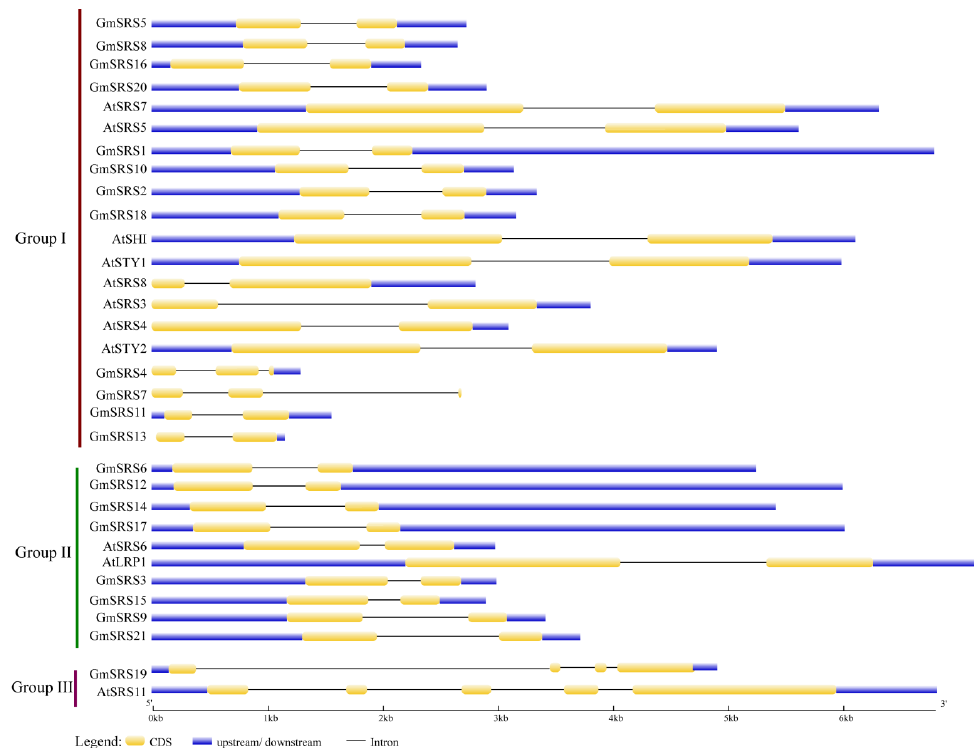
Figure 3. Intron-exon structures of SRS genes in soybean and Arabidopsis . The GSDS online tool was used to produce the intron-exon structures. The exons, introns, and untranslated regions (UTRs) are indicated by the white boxes, black lines, and gray line, respectively. Table 2. The cis-acting elements in the promoters of soybean SRS